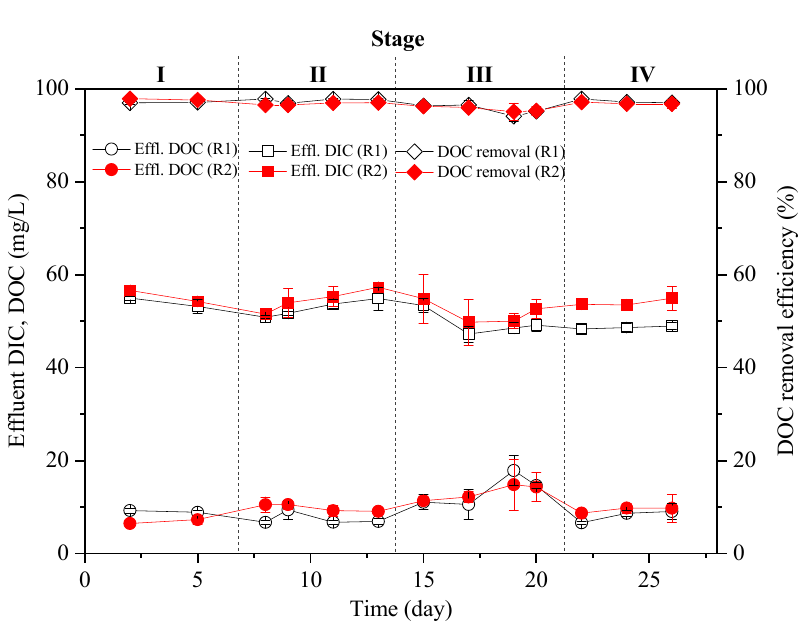
Figure 4. Variations of the effluent DOC and DIC concentrations from R1 and R2, and their DOC removals during the 28 days’ operation.